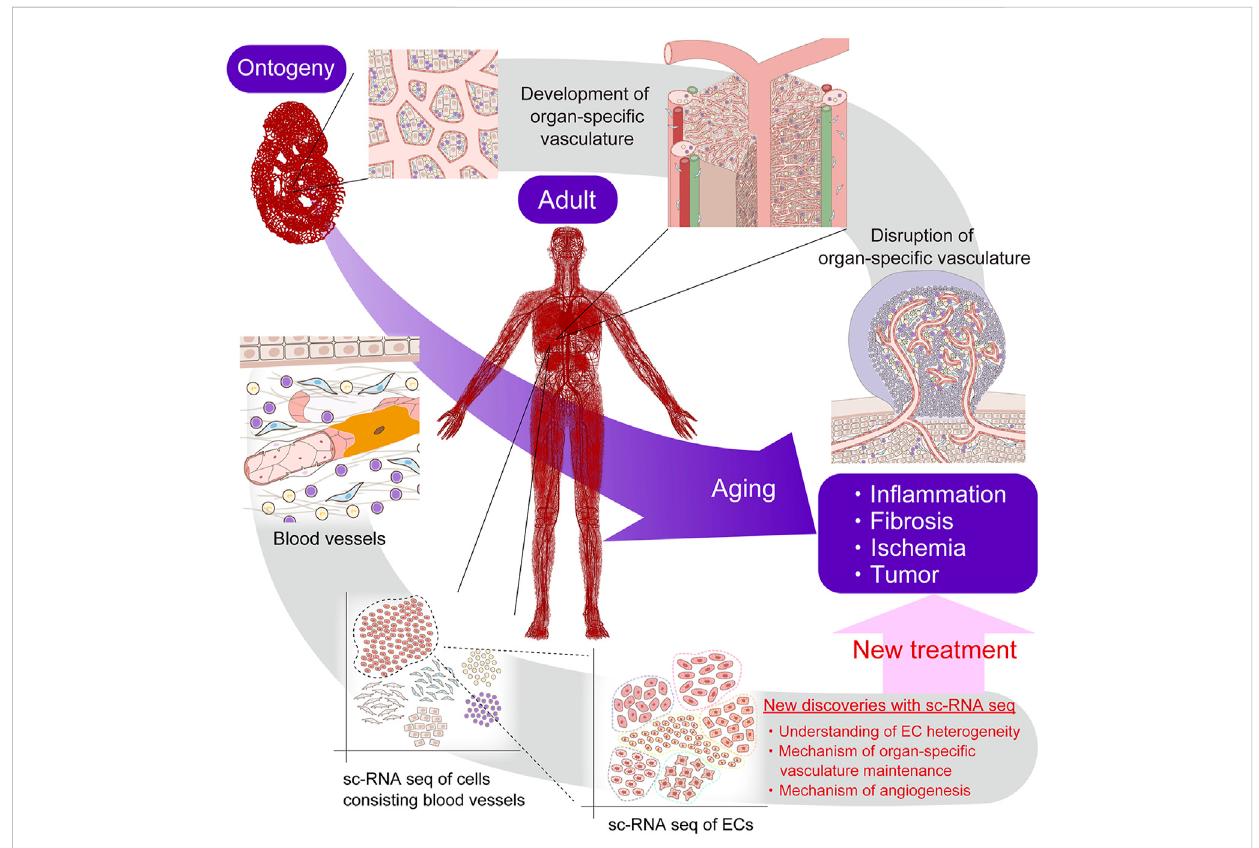
FIGURE 9 Future perspectives of single-cell RNA sequencing. Single-cell RNA sequencing is expected to elucidate vascular biological mechanisms and fi nd new therapeutic targets.